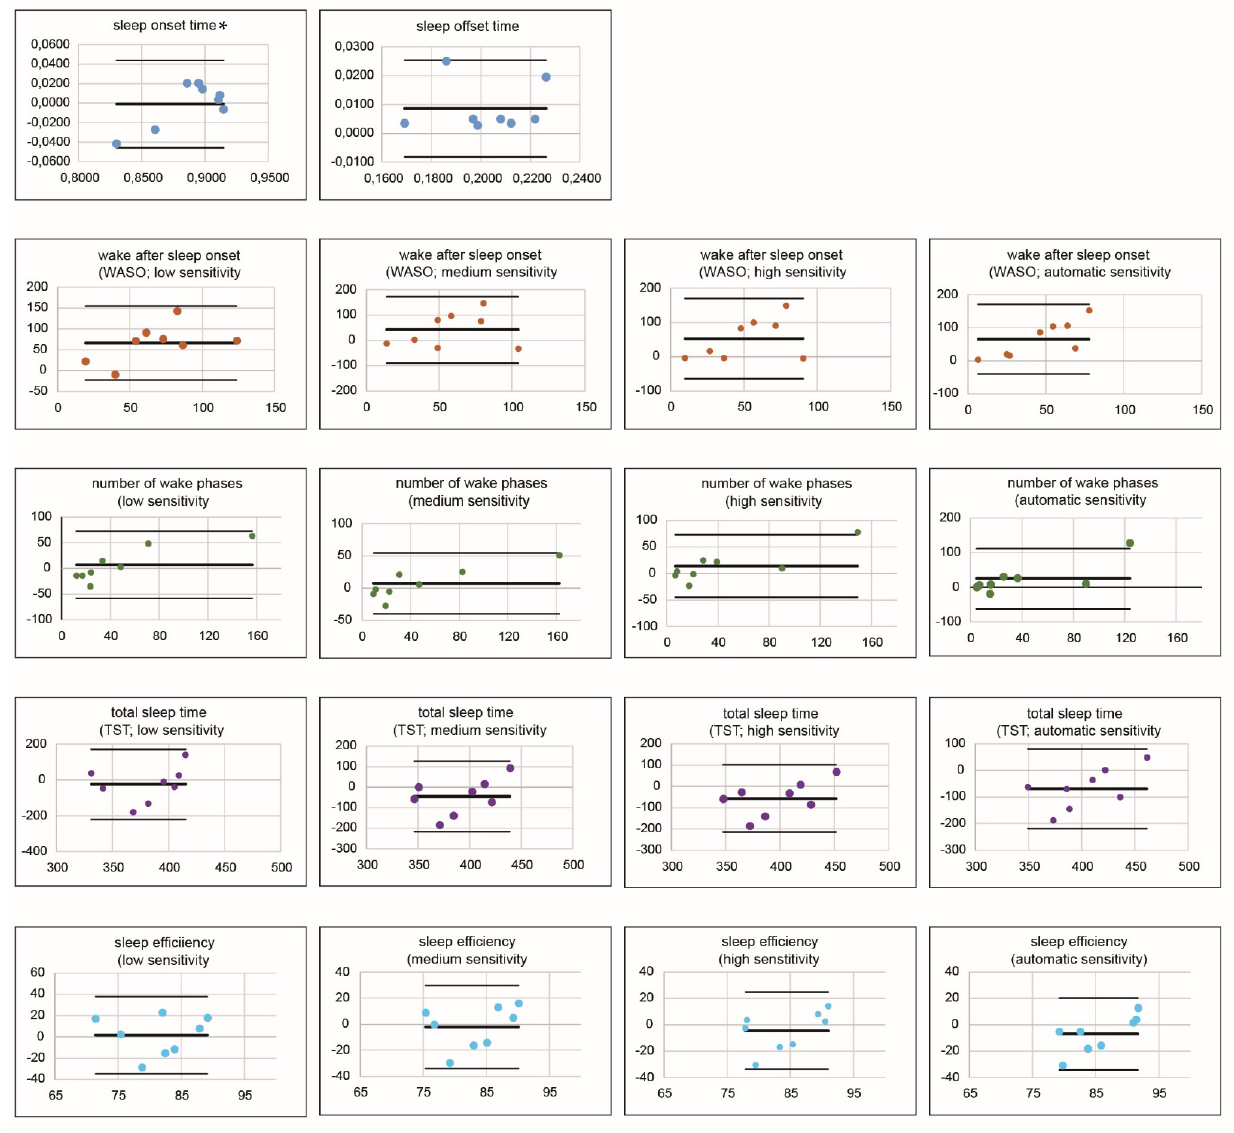
Figure 3. Bland – Altman plots for the investigated sleep parameters with the different sensitivity levels (the same color represents one sleep parameter each). * for this parameter, the normal distribution assumption could not be confirmed. The x -axis shows the mean value of the two measurement methods PSG and actigraphy, and the y -axis shows the difference between them. The differences between both measurement methods are entered as a horizontal bar in the diagram. The upper and lower limit are plotted as horizontal bars above and below the mean of the differences between the two focused measurement methods. If values are within the 95% confidence range, the second method can be said to have sufficient accuracy compared to the first